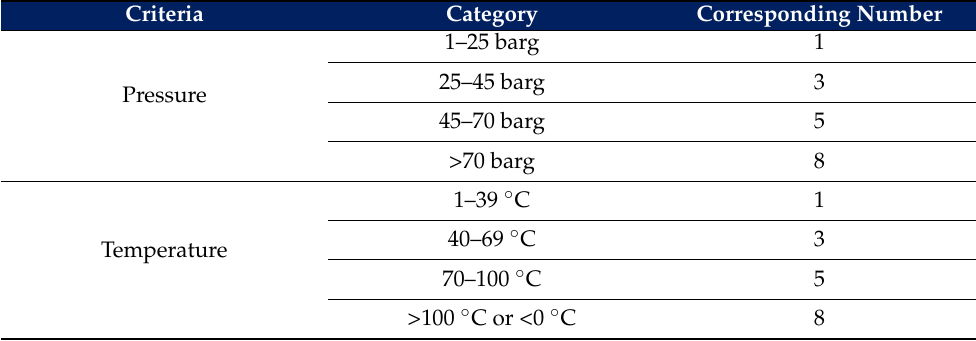
Table 5. Pressure and temperature